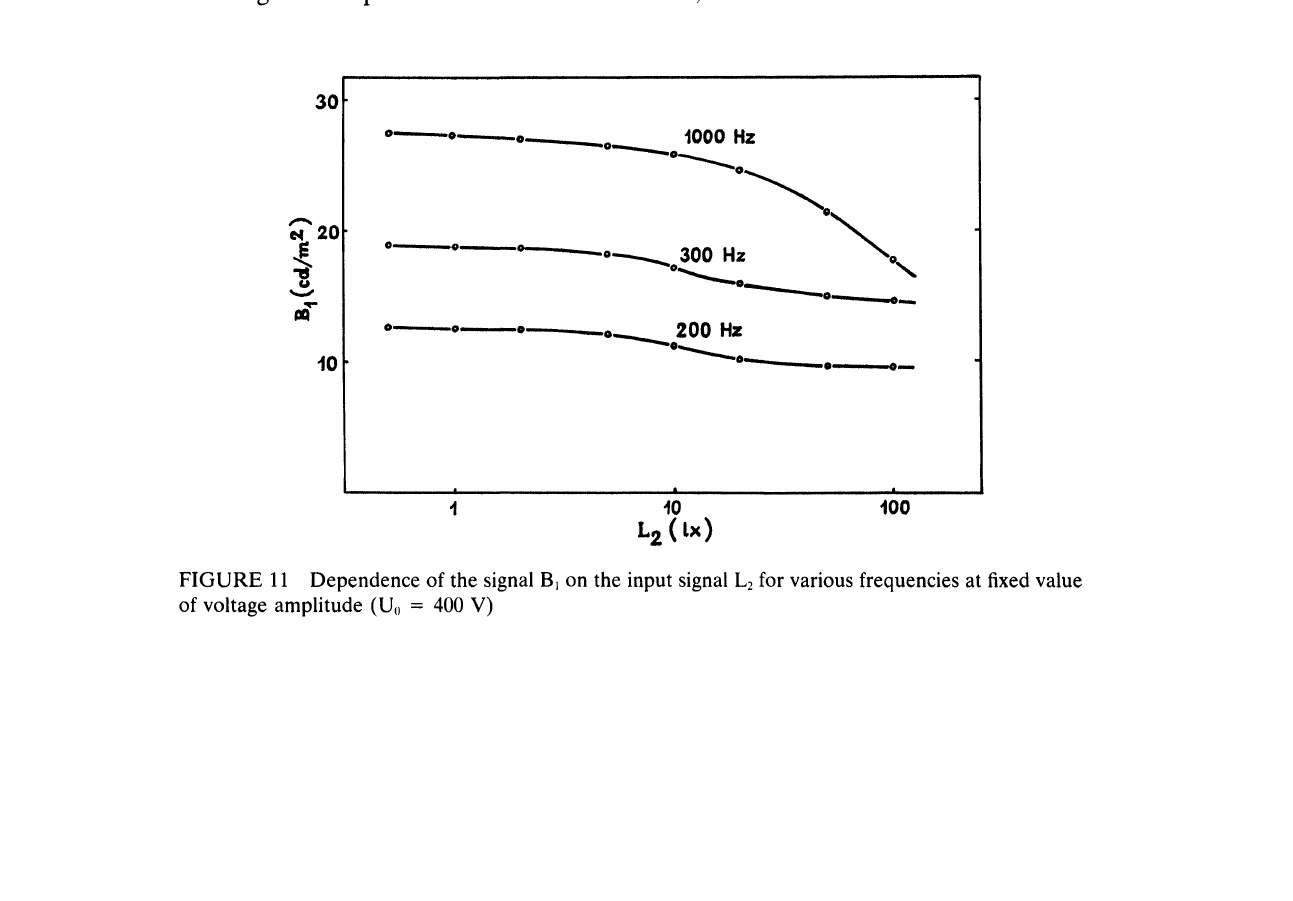
FIGURE 11 Dependence of the signal B on the input signal L2 for various frequencies at fixed value of voltage amplitude